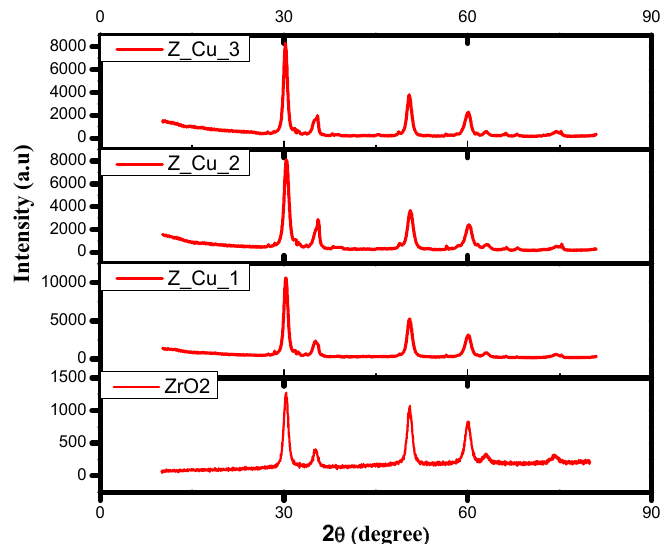
Fig. 1. XRD pattern of pure and copper doped zirconium oxide Table 1. Lattice and geometrical parameters of pure and Cu doped ZrO